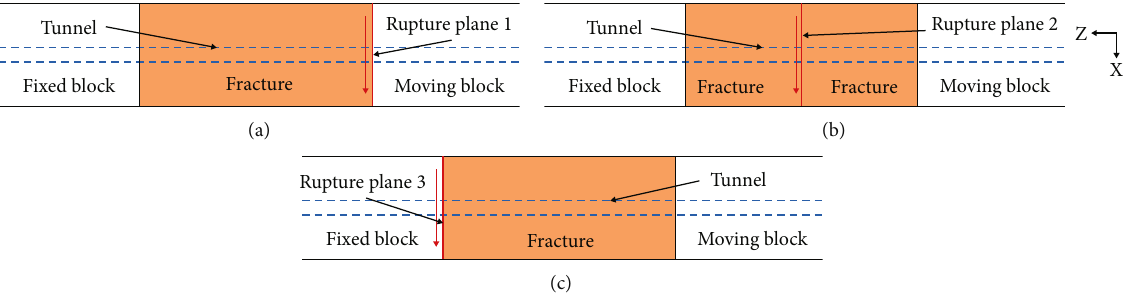
Figure 4: Schematic diagram of the di ff erent rupture planes. (a) Rupture plane 1. (b) Rupture plane 2. (c) Rupture plane 3. Table 3: Secondary lining damage index distribution on di ff erent rupture plane.